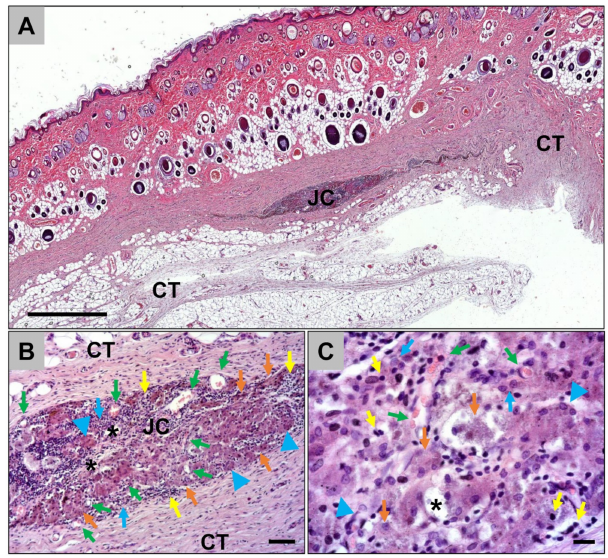
Figure 2. Representative histological images from the implantation beds of the jellyfish sca ff olds within the subcutaneous connective tissue (CT) at day 60 post implantationem . ( A ) The remnants of the jellyfish collagen sca ff old (JC) were observable at 60 days post implantationem (“total scan”, HE-staining, 10 × magnification, scale bar = 1mm). ( B ) and ( C ) The remnants of the jellyfish collagen sca ff olds (black asterisks) were surrounded by a cell- and vessel-rich (green arrows) granulation tissue at this time point. Beside macrophages (blue arrows) and multinucleated giant cells (blue arrowheads), high numbers of lymphocytes (yellow arrows) were detected. Interestingly, many macrophages showed signs of an increased cytosolic volume (orange arrows), indicating their phagocytic activity were observable (HE-stainings, A: 10 × magnification, scalebar = 50 µ m, B: 40 × magnification, scale bar = 10 µ